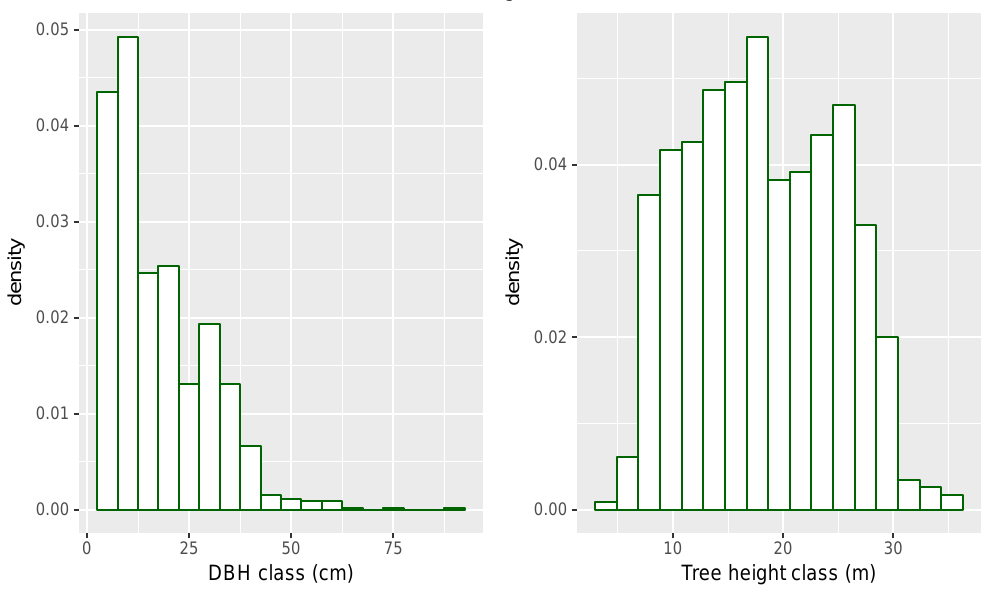
Figure 2. Diameter and tree height distributions as observed on the HIL